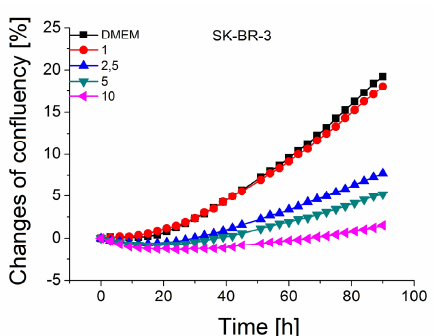
Figure 3. Proliferation assay of SK-BR-3 cells in DMEM medium and after exposure to streptavidin-modified AuNPs (1–10 µ g / mL) in PBS. The concentration of nanoparticles in µ g / mL is shown at inset.